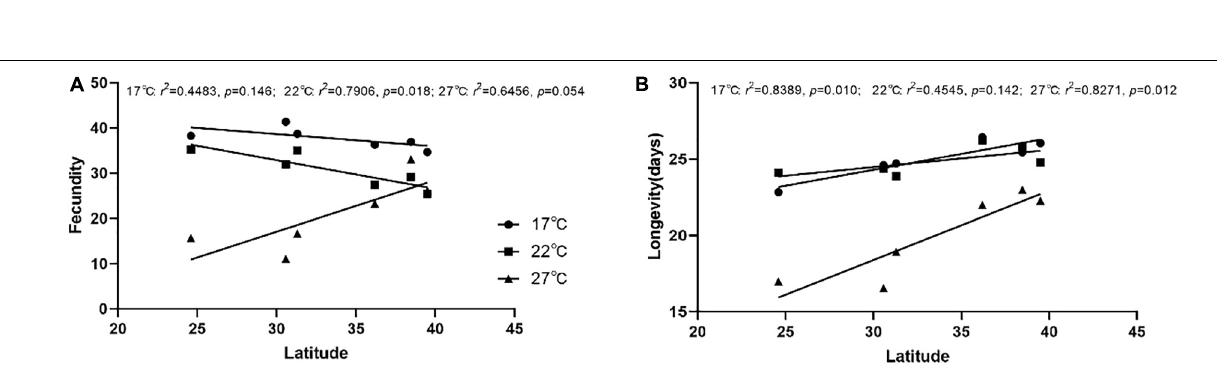
Frontiers in Ecology and Evolution |